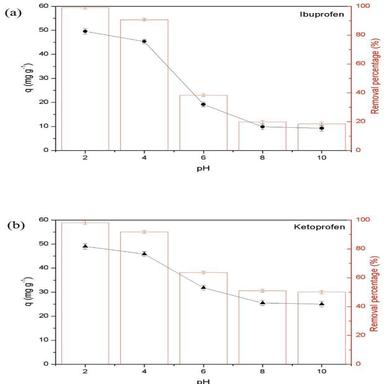
Influence of pH effect on the emerging contaminants adsorption on NiAC (a) ibuprofen (b) ketoprofen (C0 ¼ 25 mg L1 , dosage of 0.5 g L1 , 298 K, 125 rpm, 2 h).